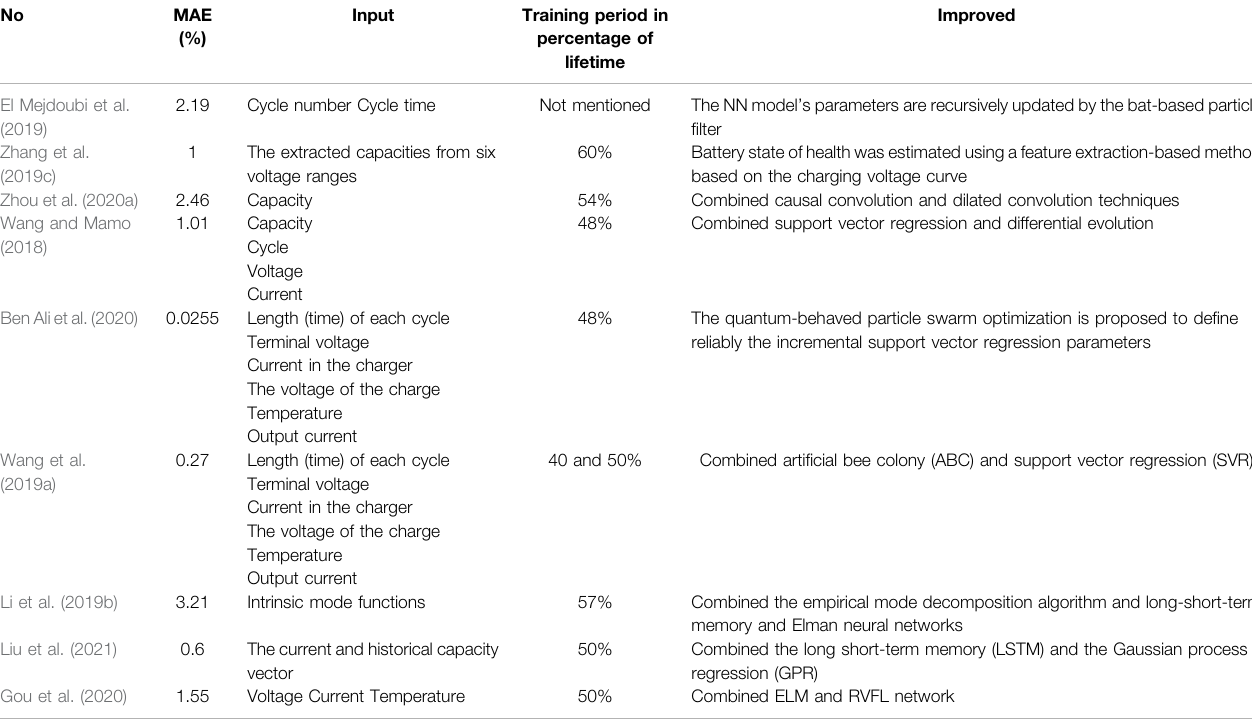
TABLE 1 | The comparison of machine learning methods